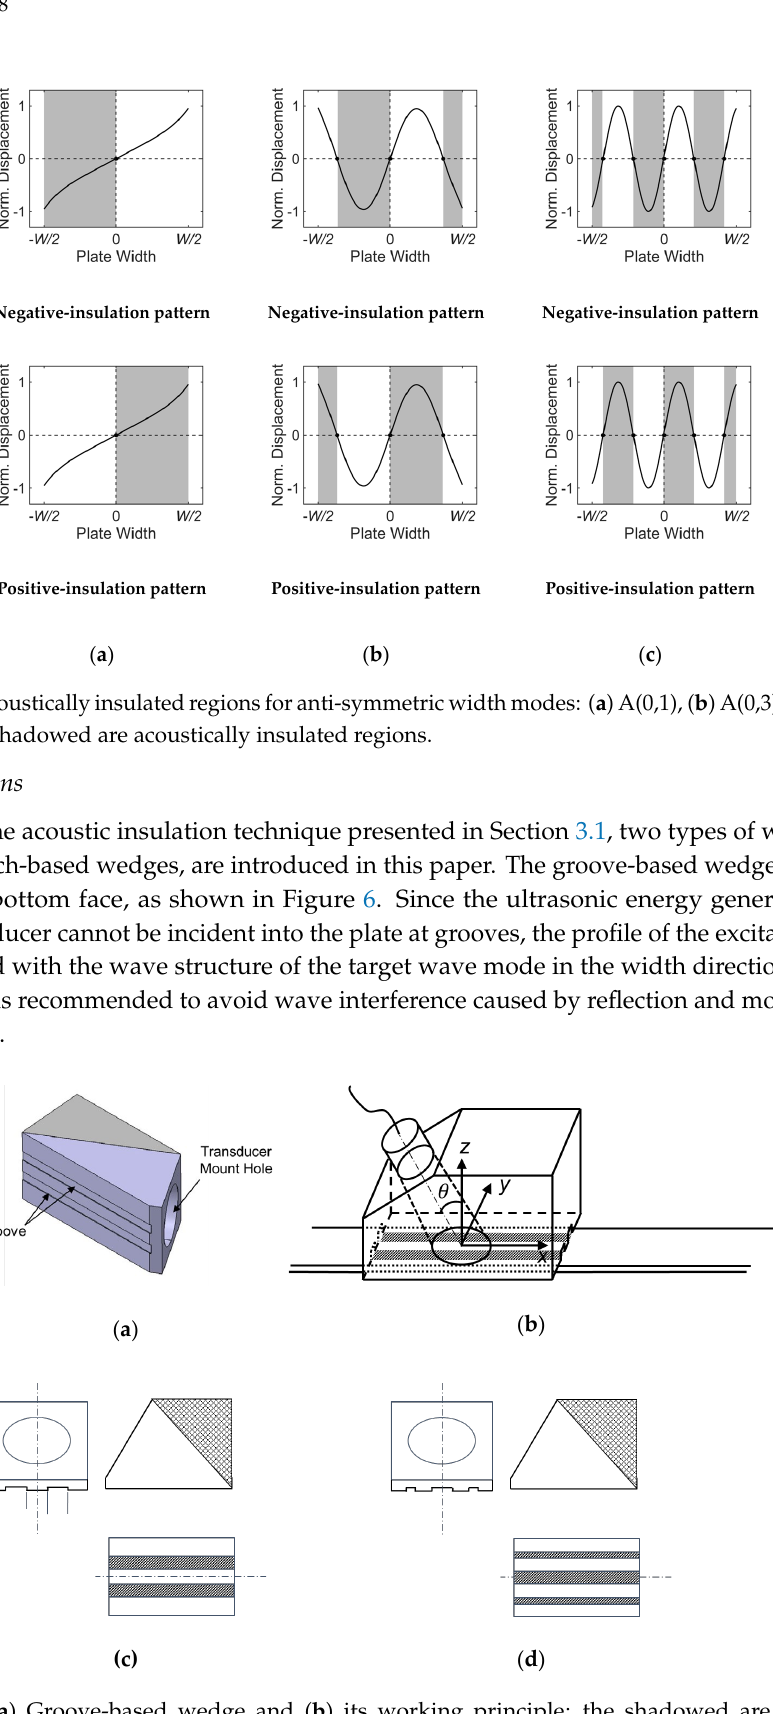
( a ) ( b ) Figure 7. (a) Patch-based wedge and (b) c ross section of the patch. 3.3. Single And Dual Wedge Techniques For the generation of a certain Lamb wave mode, a single or a dual wedge technique can be used in the proposed method. The single wedge technique uses one set of a transducer and a wedge mounted on the plate, as shown in Figure 8a; this technique is exactly the same as the conventional angle-beam excitation method. In this single wedge technique, either of the two types of insulation patterns can be used. Two types of insulation patterns can be individually used in the single wedge technique, but they can be used simultaneously in the dual wedge technique. The dual wedge technique uses two sets of a transducer and a wedge mounted on the top and bottom surfaces of the plate, as shown in